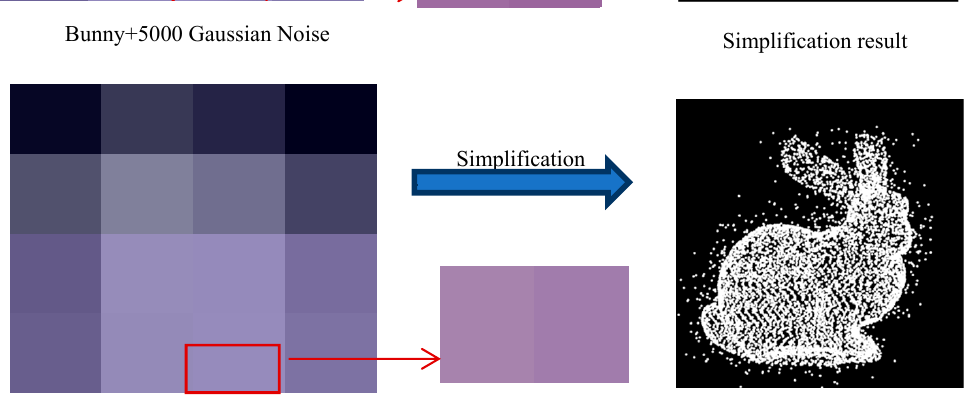
Table 5. The noise simplification ratio r using the different simplification algorithms. Amount of Noise ( t )